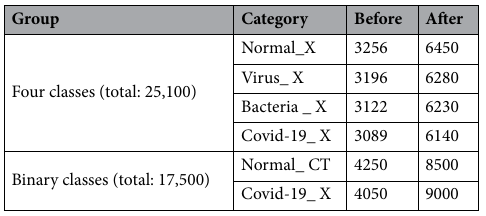
Table 1. The dataset distribution before and after augmentation.